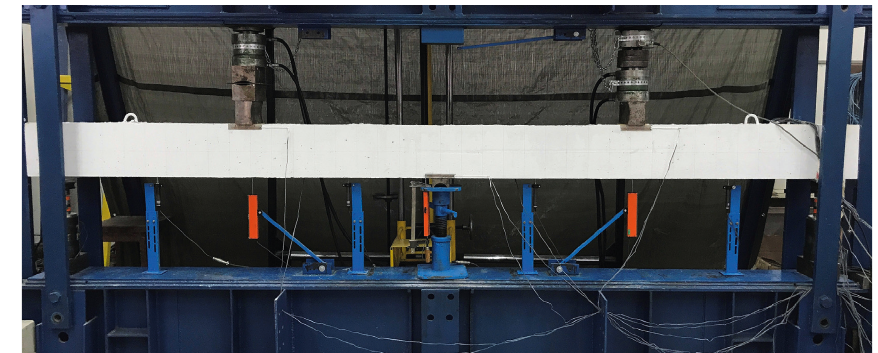
Figure 4: Equipped continuous beam before